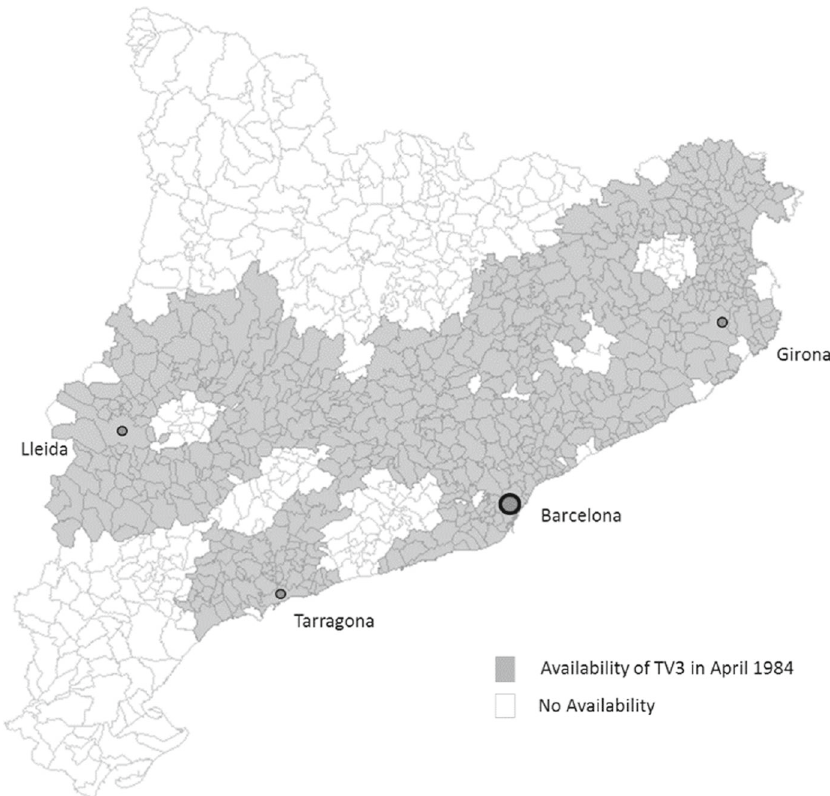
Fig. 1 Availability of TV3 in Catalonia in April 1984. Source : Prepared by the author based on (Montero 1987) and La Vanguardia (“Appendix 2”)